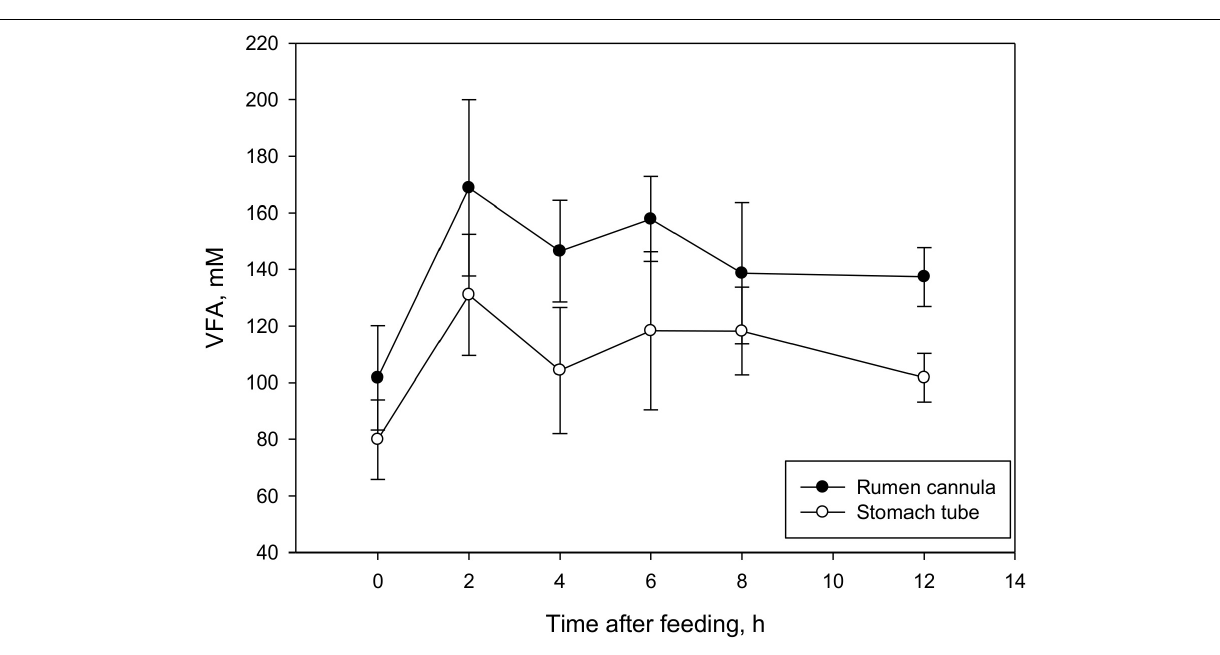
FIGURE 2 | Effect of sampling techniques (rumen cannula vs stomach tube) on total volatile fatty acid (VFA) concentration (m M ) in lactating dairy cows (means ± SE; n = 69). Overall sampling method effect, P < 0.001; time of sampling effect, P < 0.001; sampling method × time of sampling interaction, P =